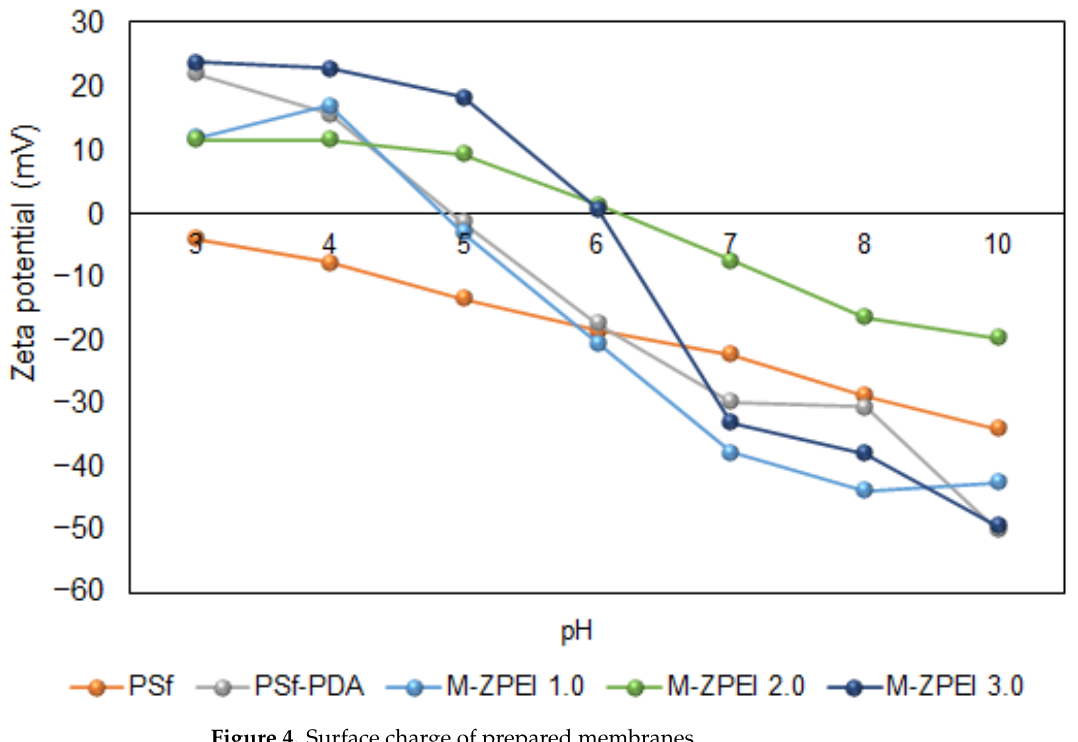
Figure 4. Surface charge of prepared membranes.